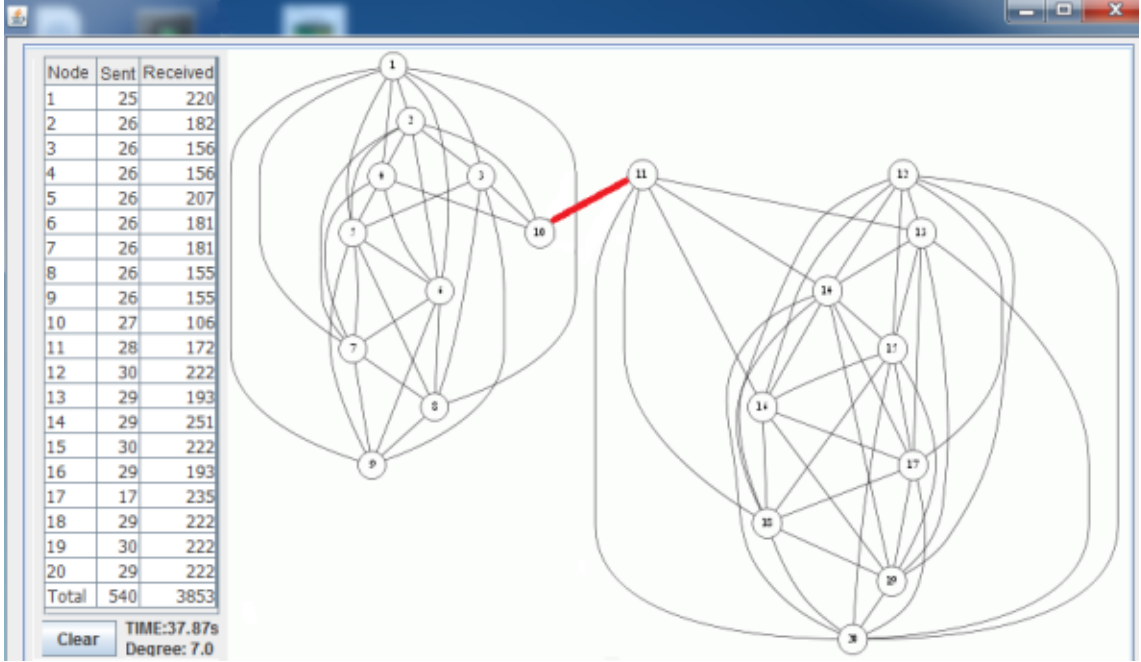
Figure 10. Snapshot of the monitoring program for the dense topology.